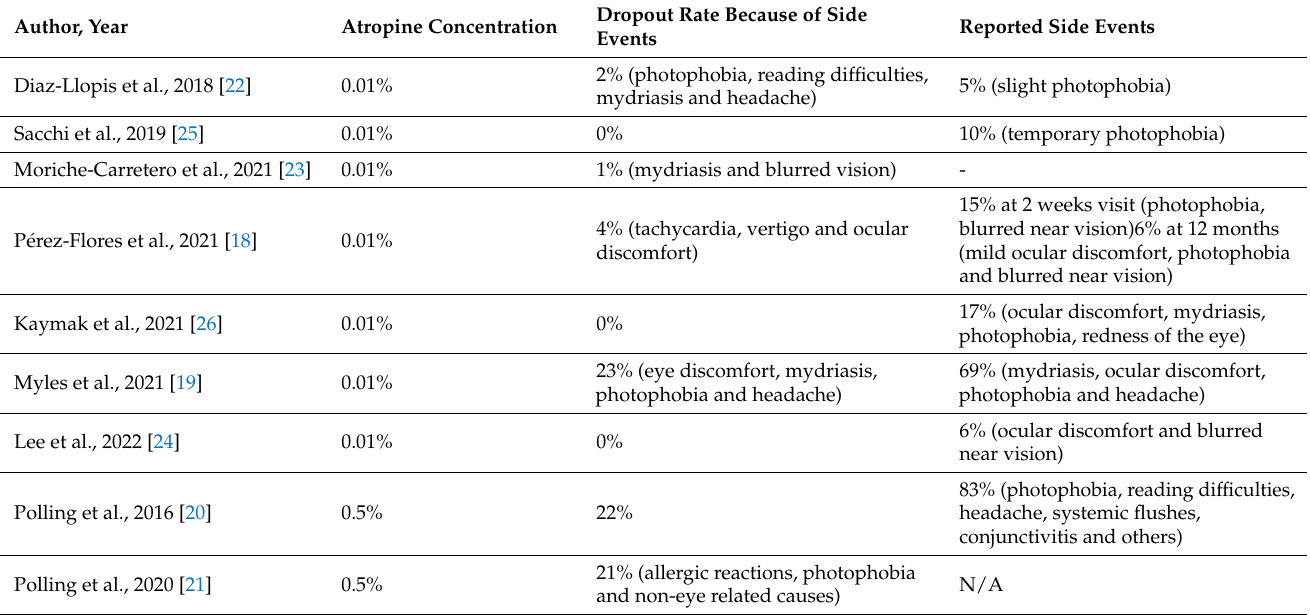
Table 4. Comparison of frequency of adverse events between studies included in the